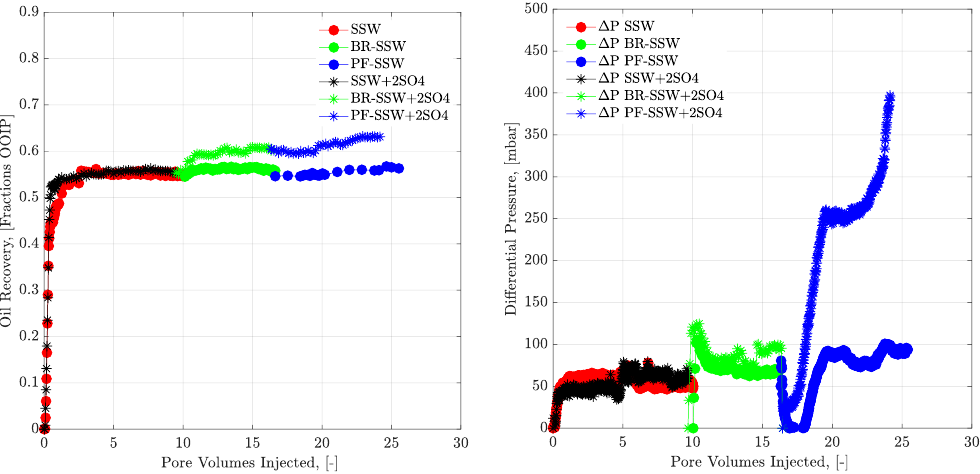
Figure 22. Oil recovery and pressure drop versus PV injected for water-wet real structure micromodel. Polymer (equal to the oil viscosity) flooding in tertiary mode after the SSW + 2SO 42 − / SSW brine flood in secondary mode.